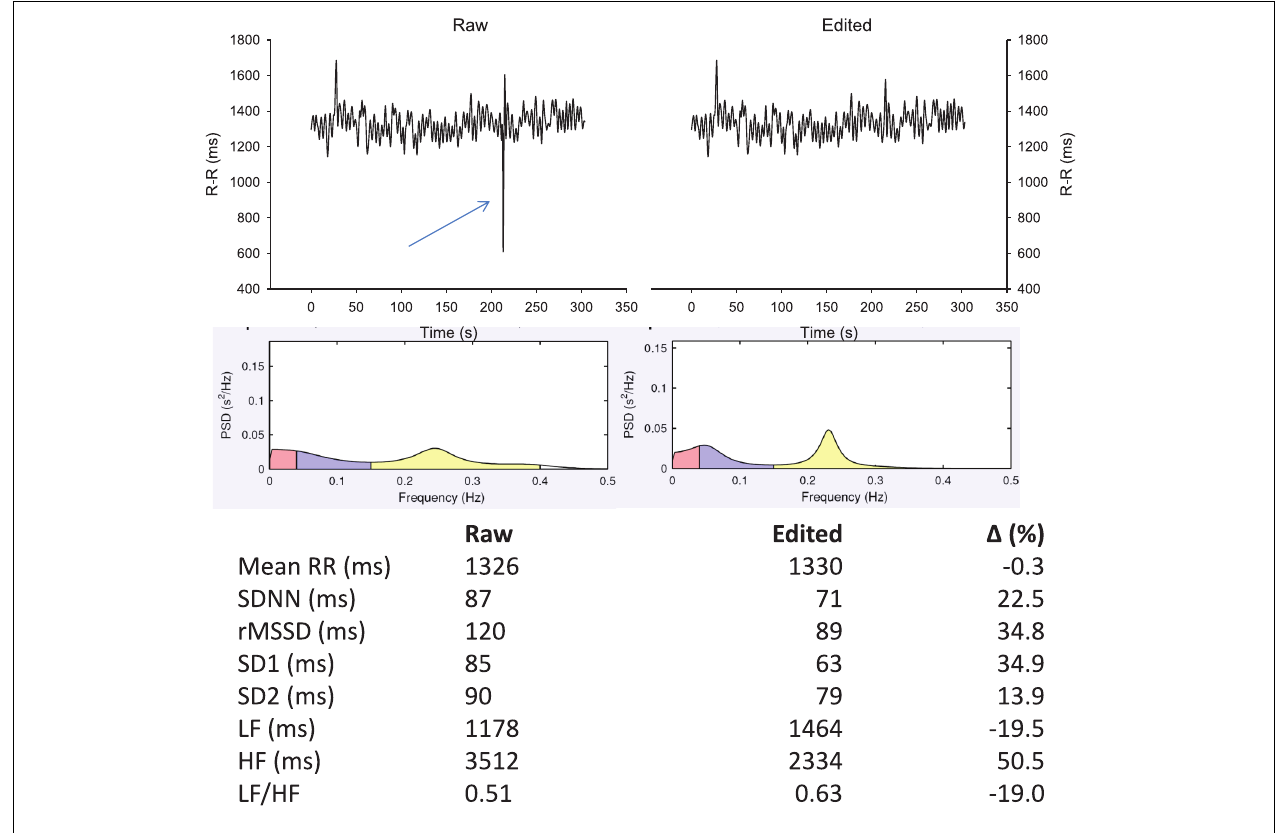
FIGURE 3 | Effect of an ectopic beat on traditional heart rate (HR) variability (HRV) indices. R-R intervals recorded in supine position for 5min with data either non-edited (upper left panel) or with beat removal and linear interpolation with adjacent values (upper right panel). Middle panels show the associated power spectral density (PSD) distribution on a spectrogram (Kubio HRV, 2.1, Biosignal Analysis and Medical Imaging Group, Kuopio, Finland) and lower panels, the common HRV indices derived from those